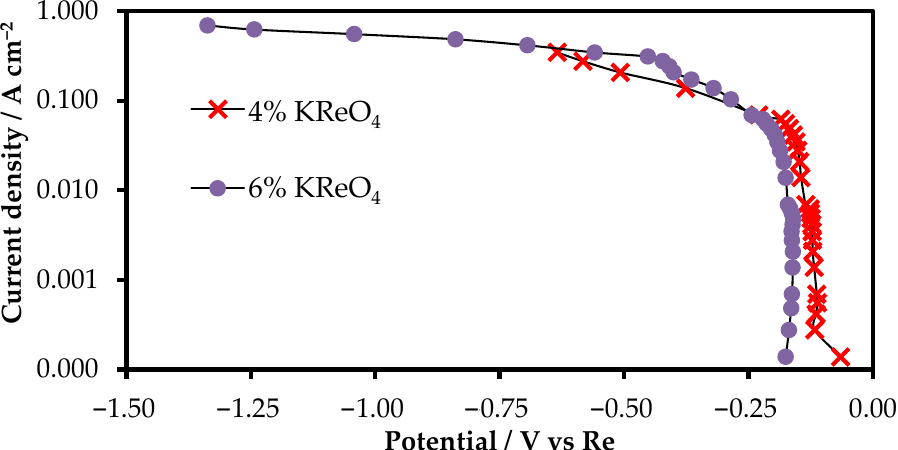
Figure 6. Stationary polarization curves of KReO 4 in molten KF-KBF 4 -B 2 O 3 on a platinum wire electrode. RE:Re; CE:Re.